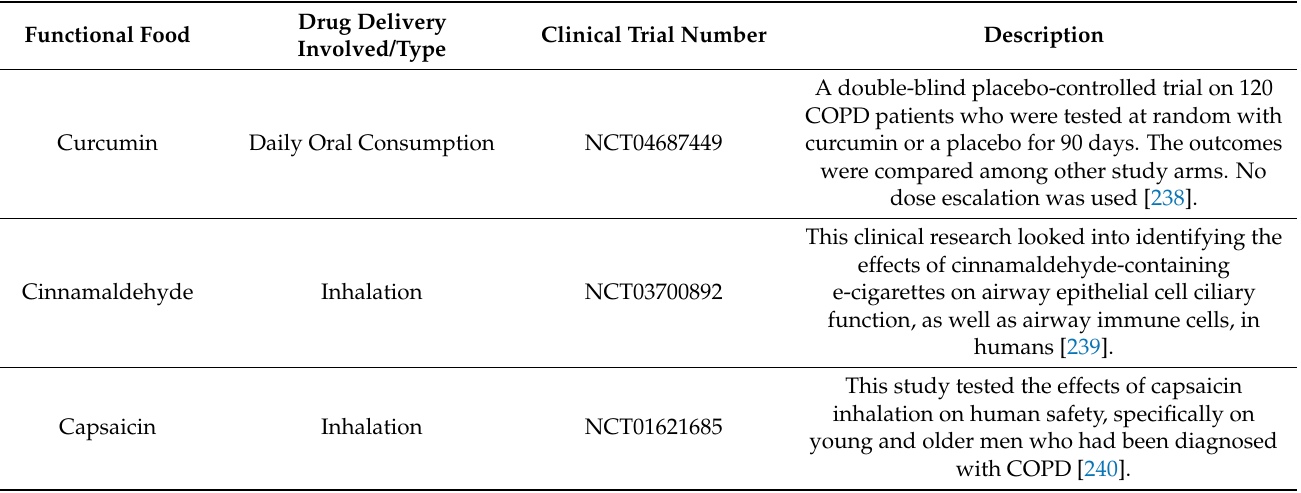
Table 4. Notable clinical studies involving functional foods for COPD and other relevant lung dis-